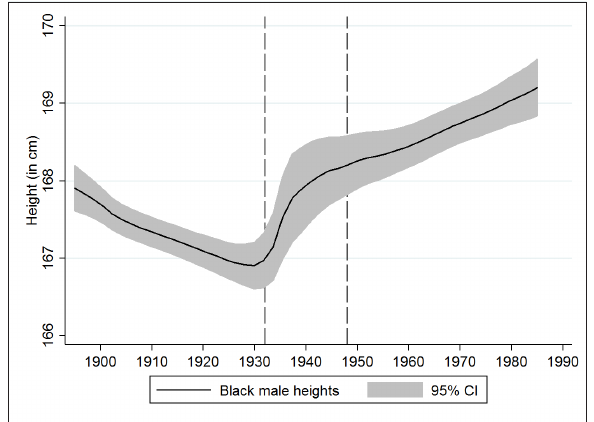
Figure 3: Height of black men by year of birth, 1895–1990. Black men born during the late-19th century were on average 168 cm tall. Average height then fell by 1 cm to 167 cm over the course of the next three decades, suggesting a strong deterioration in living standards.